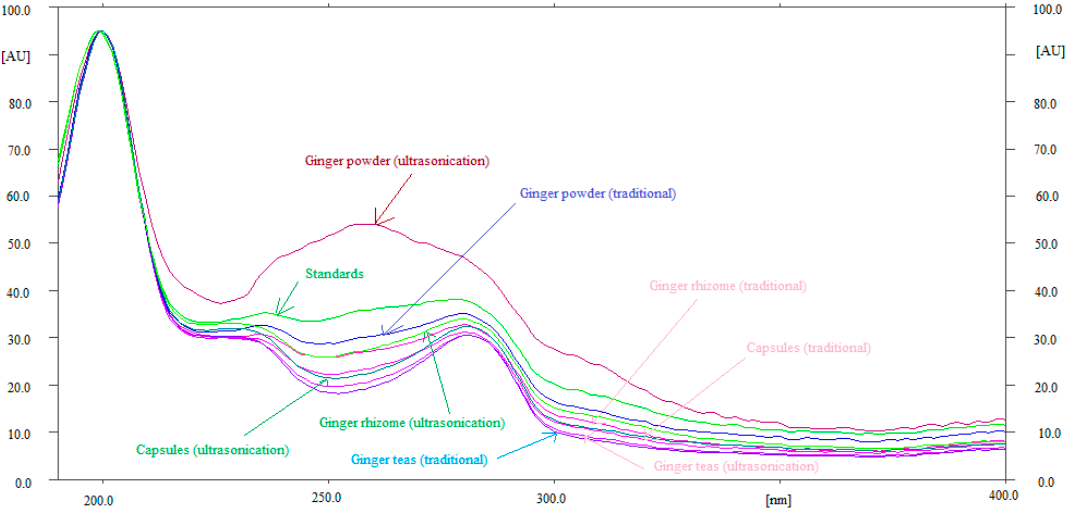
Figure 3. Overlaid ultra-violet (UV) absorption spectra of standards (6-SHO and 6-GIN), ginger rhizome, ginger powder, commercial capsules, and ginger teas extracted from traditional and ultrasonication methods.